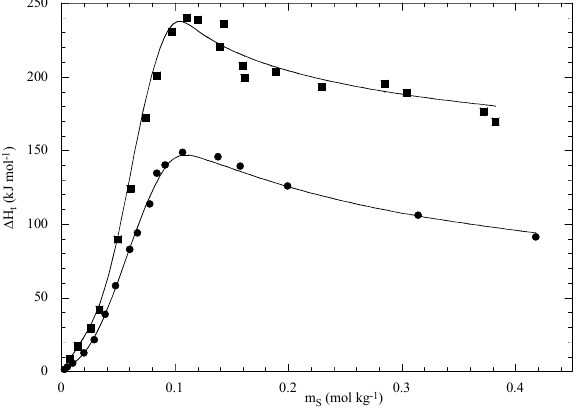
aqueous sodium decanoate at 298 K. Lines are best fits according to Equation 13. Data are from refs.